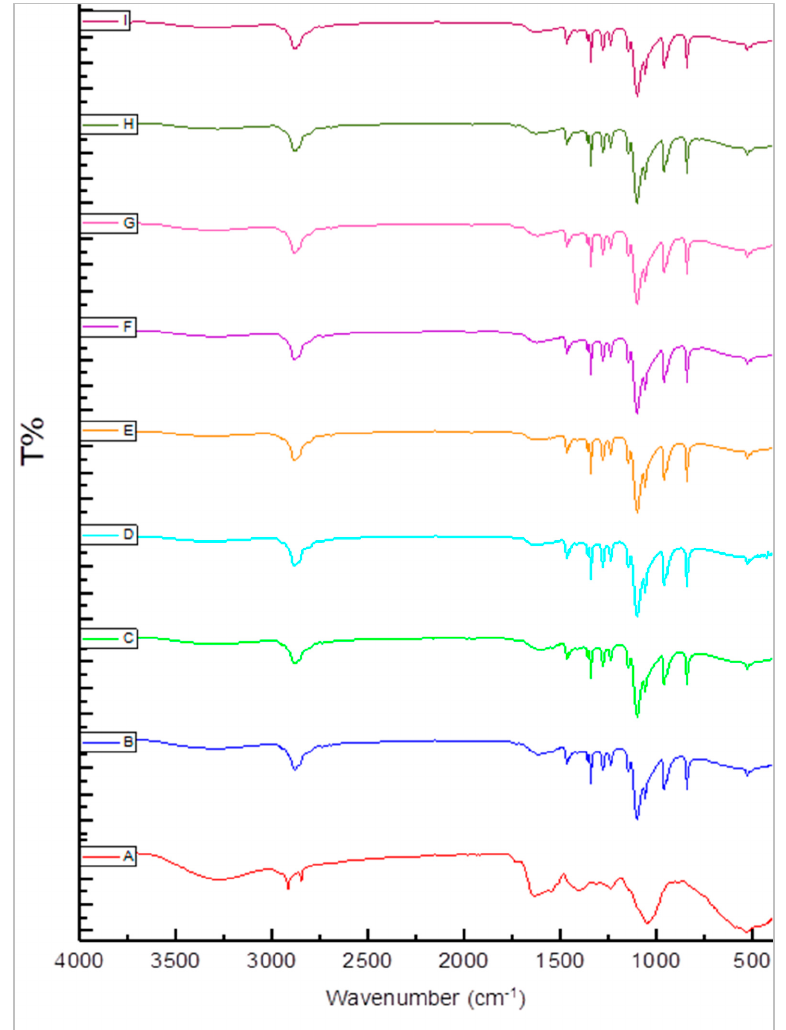
Figure 10. FTIR spectra of ( A ) pure Moringa oleifera leaf powder (MOLP), ( B ) Solid dispersed Moringa oleifera leaf powder (SDMOLP) prepared by the freeze ‐ drying method (MOLP ‐ PEG4000), ( C